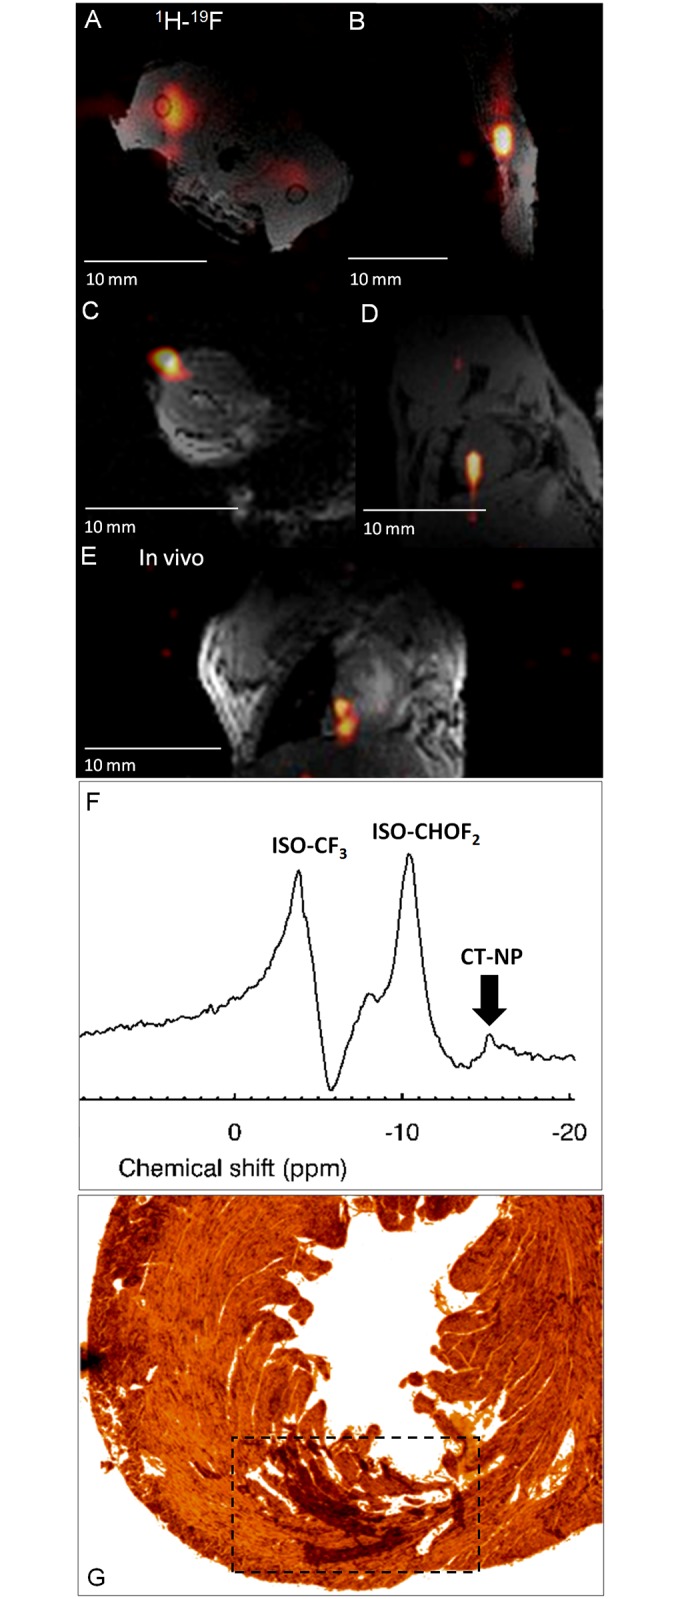
Post-mortem and in vivo murine cardiac 19F MRI following intramyocardial CPC injections.Post-mortem (A-D) and in vivo (E-F), merged 1H-19F images of approximately 1.5–2.5 million labeled CT cells administered in the (A, B) femoral skeletal (axial, sagittal views; both legs were injected), (C, D) post-mortem cardiac (pseudo-short and short-axis views, without (C) and with the anterior thorax (D)) from PHD3f/f, PHD2flox/flox, (E) ungated in vivo cardiac (coronal) views from a C57BL/6 mouse using the butterfly coil. (F) Corresponding ungated, unlocalized 19F MRS from the upper thorax showing the two isoflurane (ISO) and the labelled CT cell peaks. All 1H images were acquired when the coil was tuned/matched at the 19F resonance. (G) Indicative optical bright field histological image from the mouse heart in (D) above. The dotted square box indicates the area where cells were localized within the left ventricular myocardium.